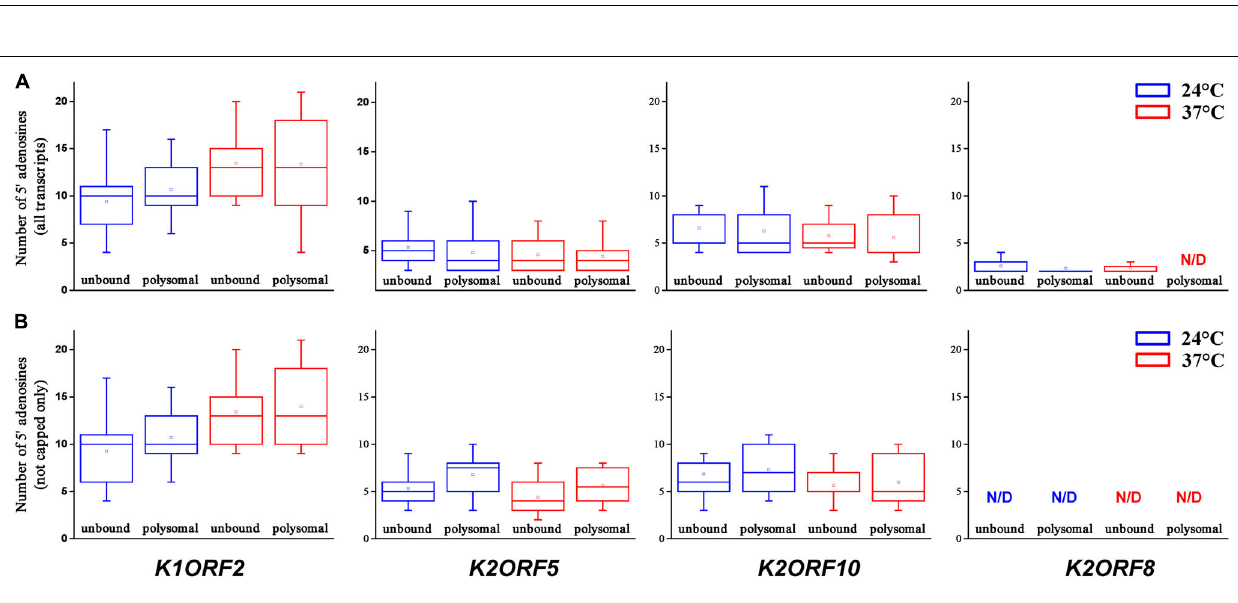
Frontiers in Microbiology |